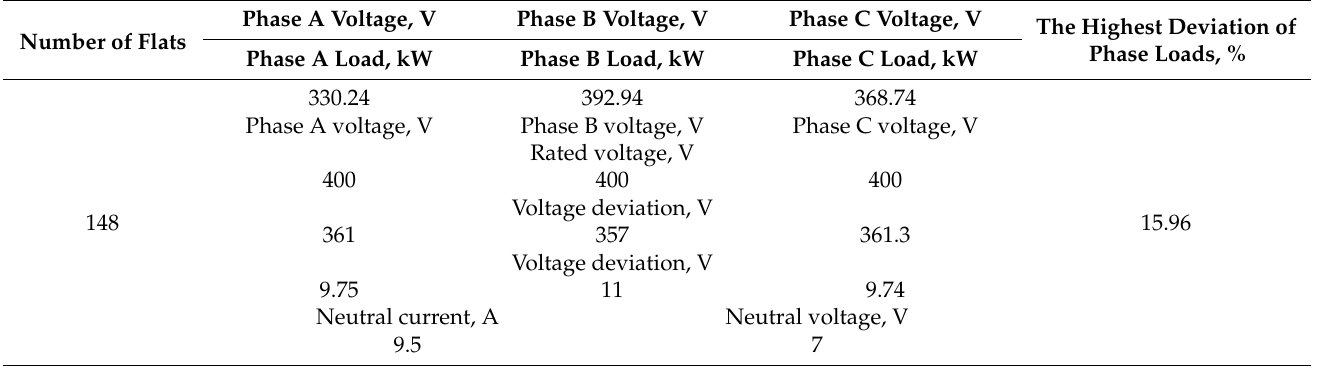
Table 5. Individual phase load values during peak load hours for the first